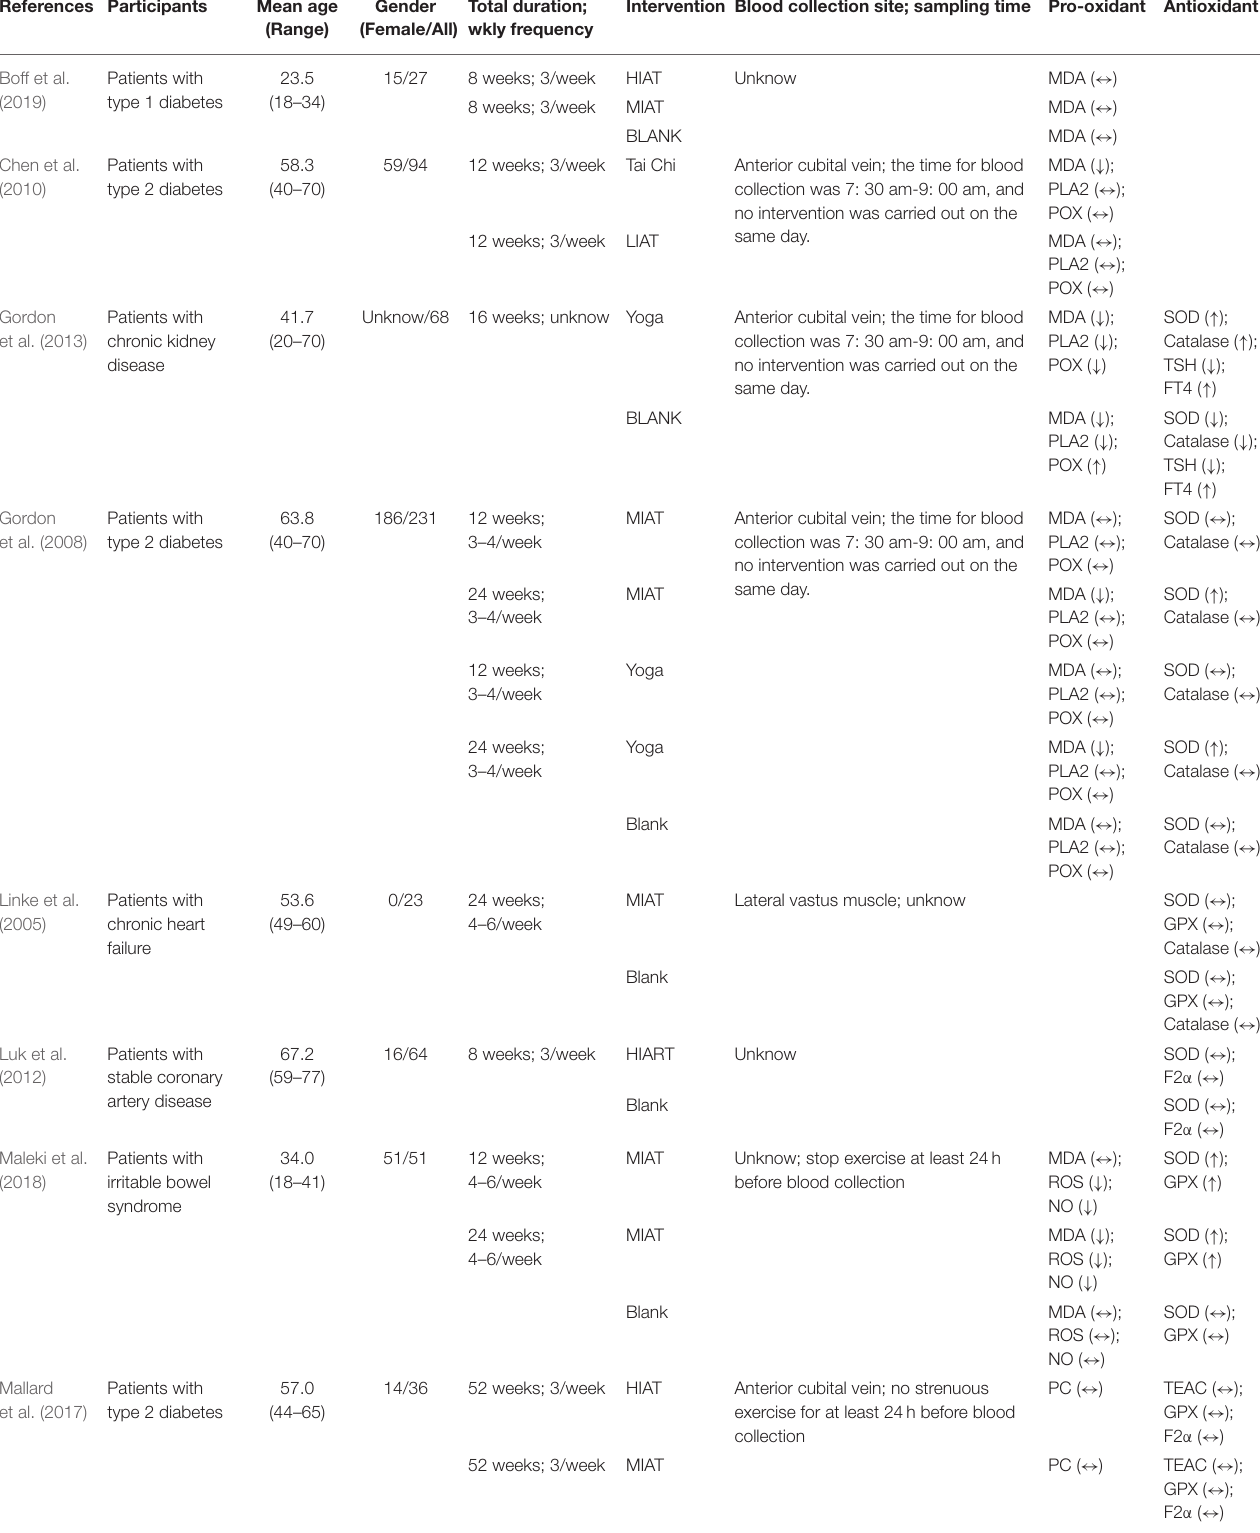
TABLE 1 | The study characteristics of included